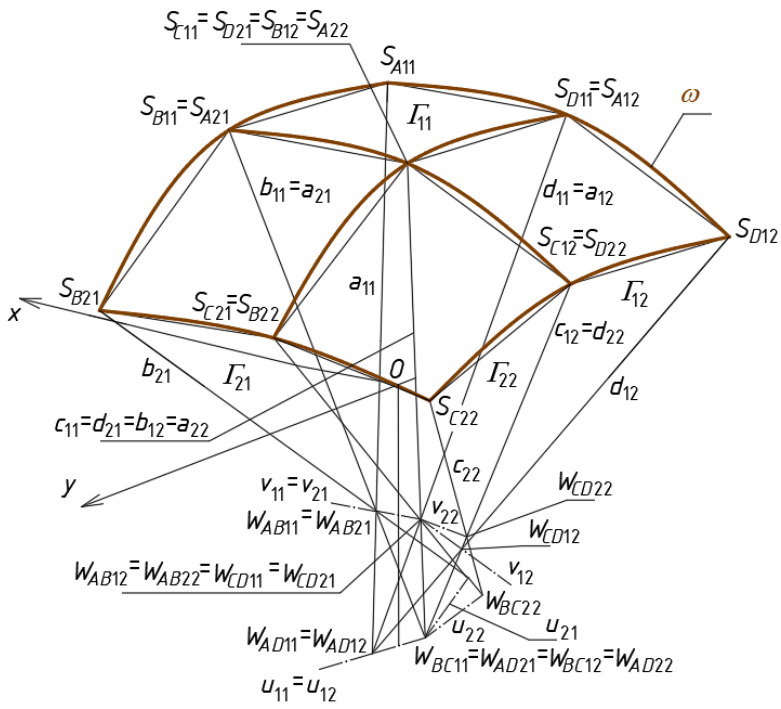
Figure 9. A reference regular surface ω based on the modified polyhedral network Γ .